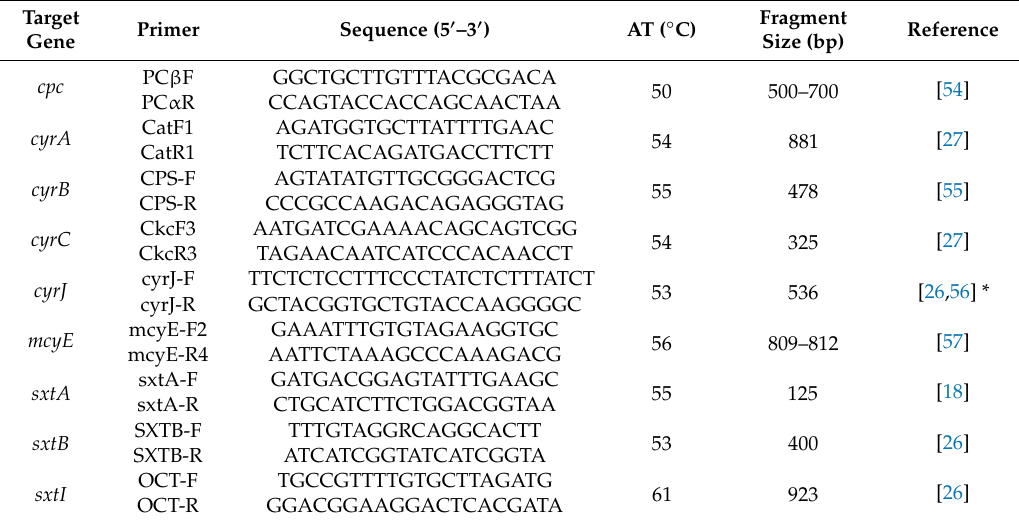
Table 1. List of primers used in this